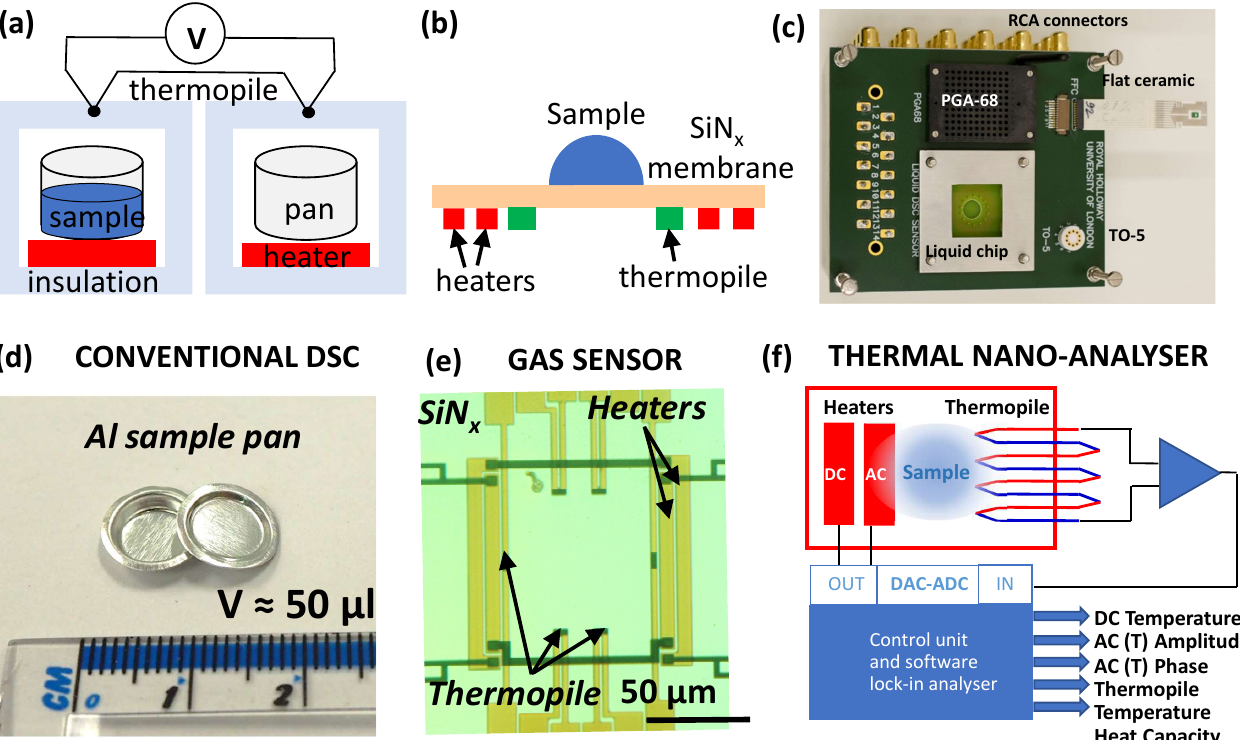
Figure 1. Thermal analysis using conventional differential scanning calorimetry (DSC) and thermal nano-analyzer. Schematics of ( a ) DSC instrument with two macroscopic pans for sample and reference; ( b ) sensor with two uninsulated heaters and thermopile placed on a 1 µ m thick SiNx membrane, the sample may be in ambient atmosphere or in liquid, whilst non-conducting liquids are compatible with both sides of the sensor membrane, ( c ) sensor adapter compatible with 15 nL thermo-responsive liquid chip as well as gas sensor in TO-5, PGA-68 and flat ceramic housing, ( d ) commercial